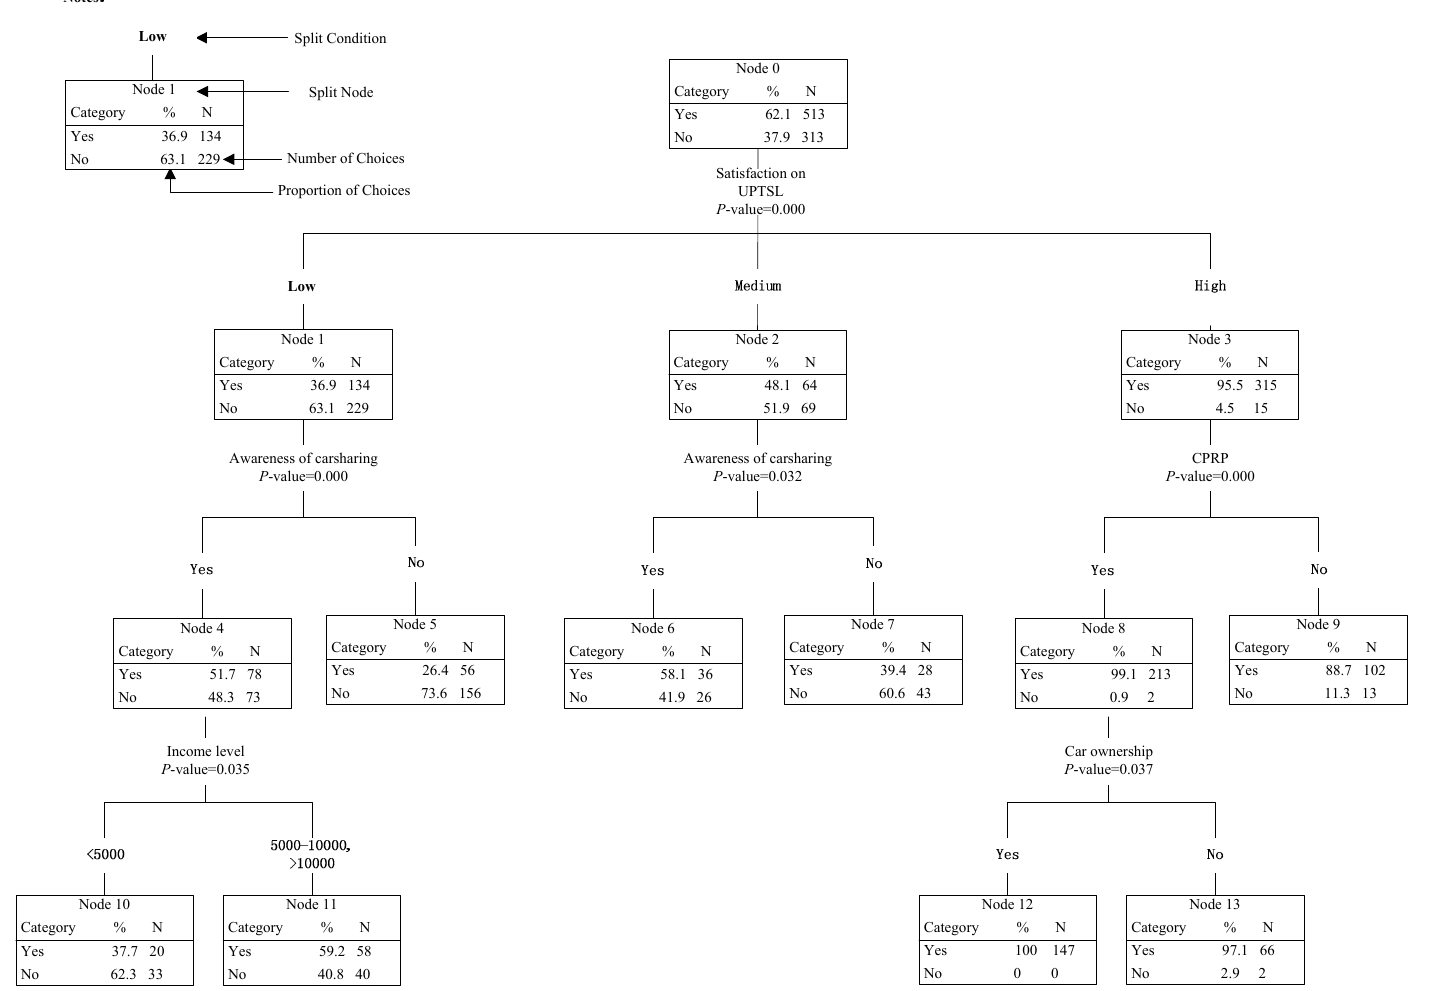
Figure 7. HTBR Model #4: Predicting participants’ willingness to forgo car purchases.